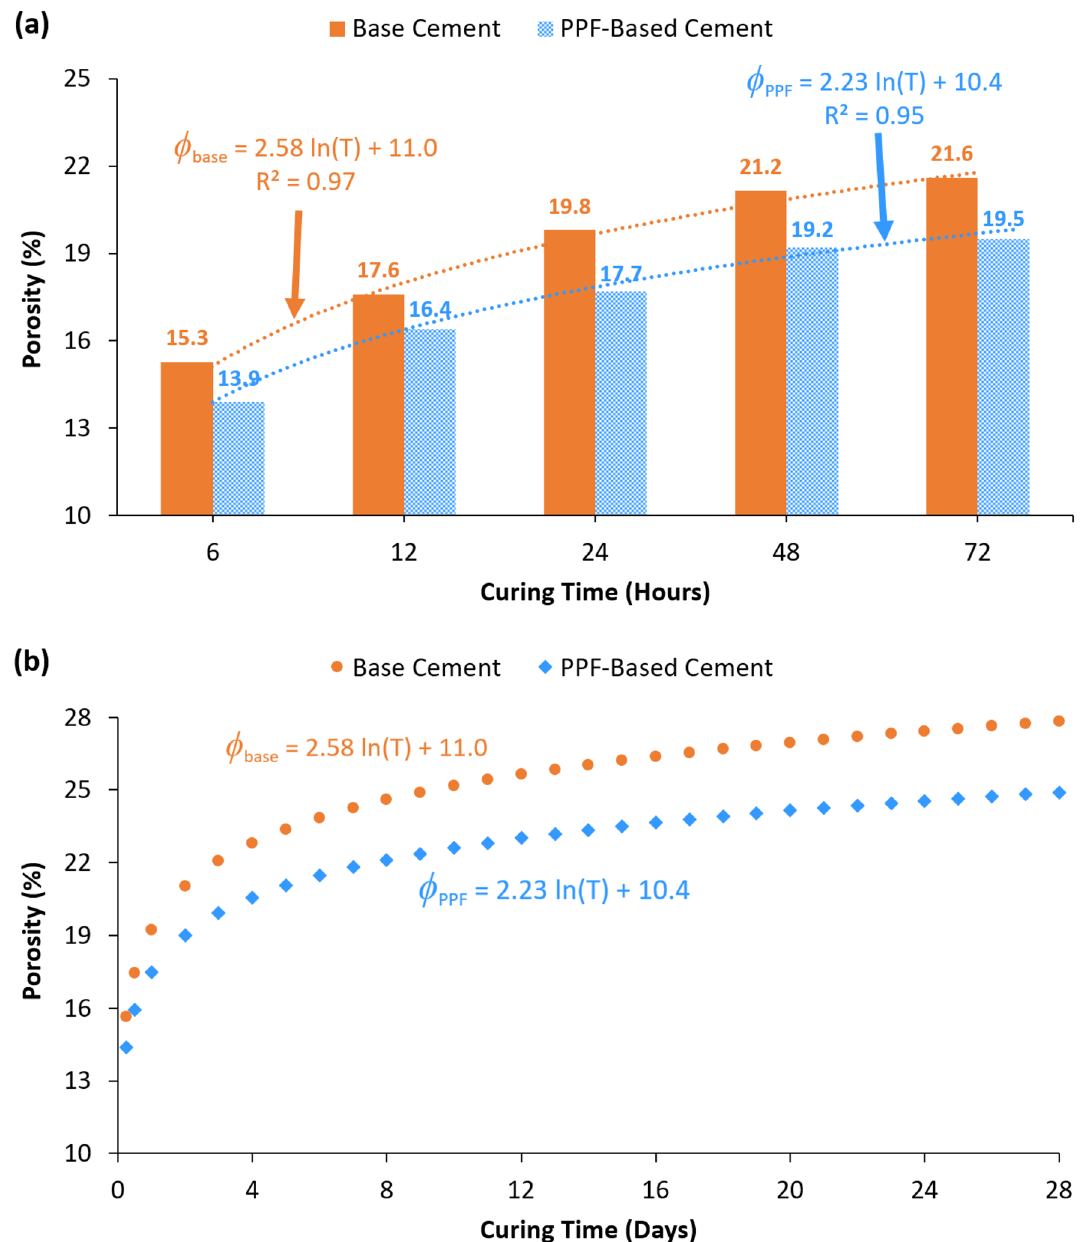
Fig. 7 Porosity for the polypropylene and base specimens at various stages of curing. a The findings of the porosity measurements during the early curing times. b The anticipated variations in porosity over 4